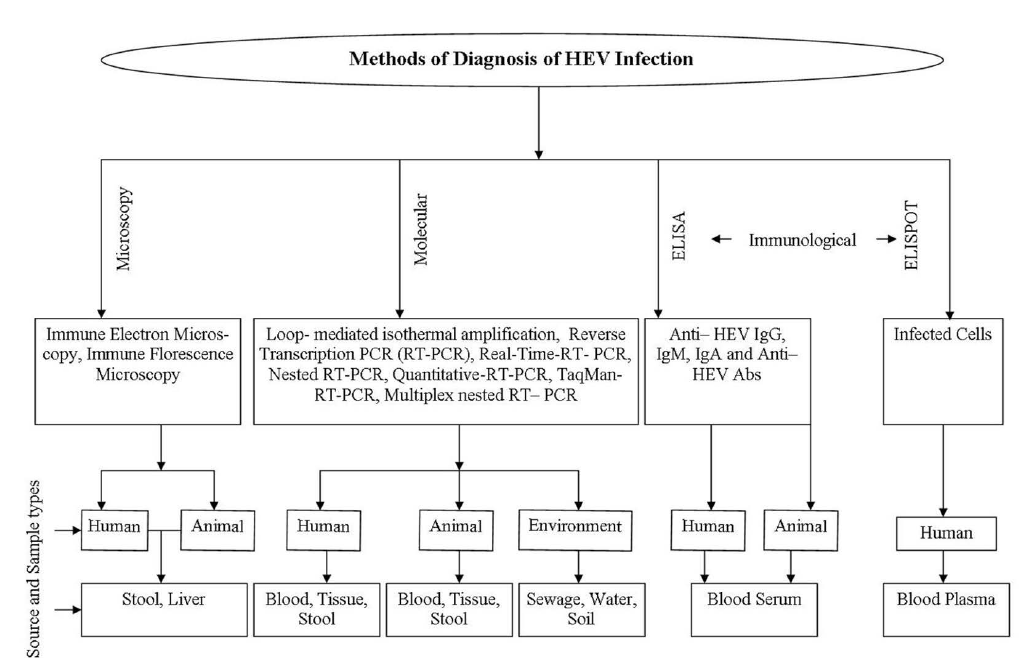
Fig. 2. Different approaches used for the diagnosis of Hepatitis E virus (HEV) 6,